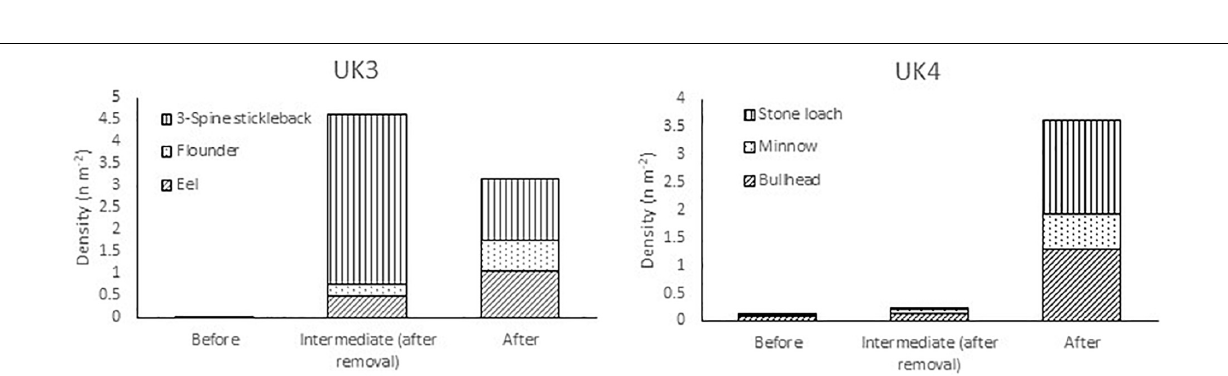
FIGURE 6 | Change in density of three-spined stickleback, Gasterosteus aculeatus , flounder Platichthys flesus , and European eel Anguilla anguilla at site UK3 and change in density of stone loach Barbatula barbatula , Eurasian minnow Phoxinus phoxinus , and bullhead Cottus perifretum at site UK4. (Only species with density > 0.1 m 2